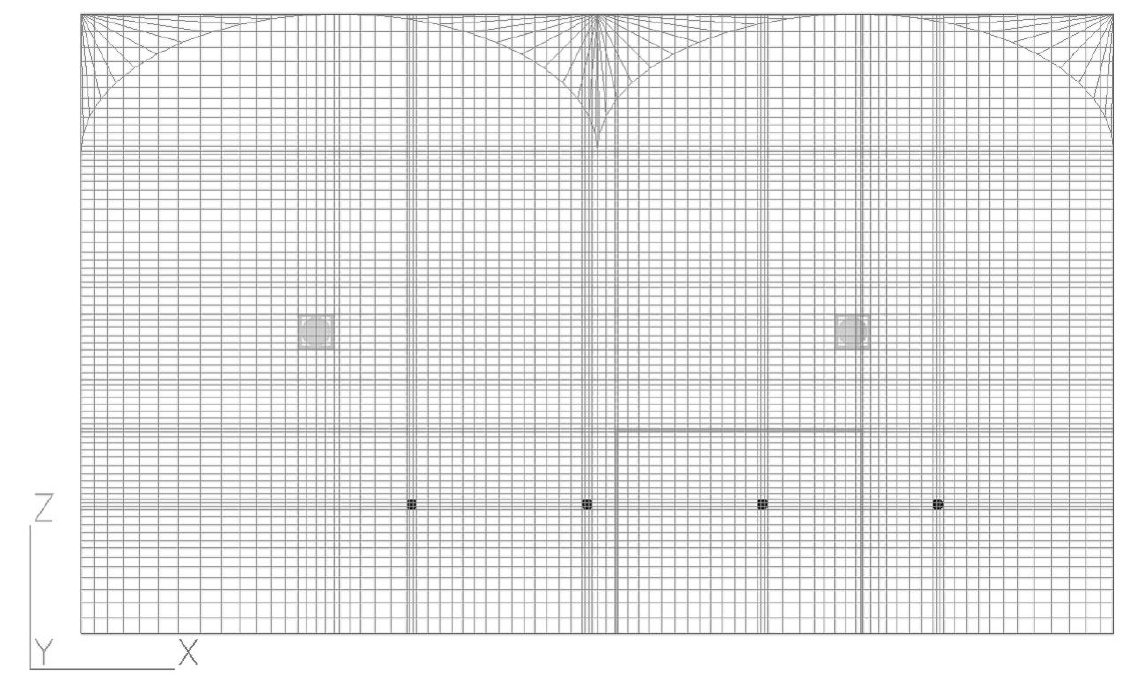
Figure 7. Meshing of greenhouse model: (the four rectangular shapes inside the chamber represent the plants, the circles represent CO 2 perforated tube, and the squares represent fans). Table 2. Computational conditions used for greenhouse model.